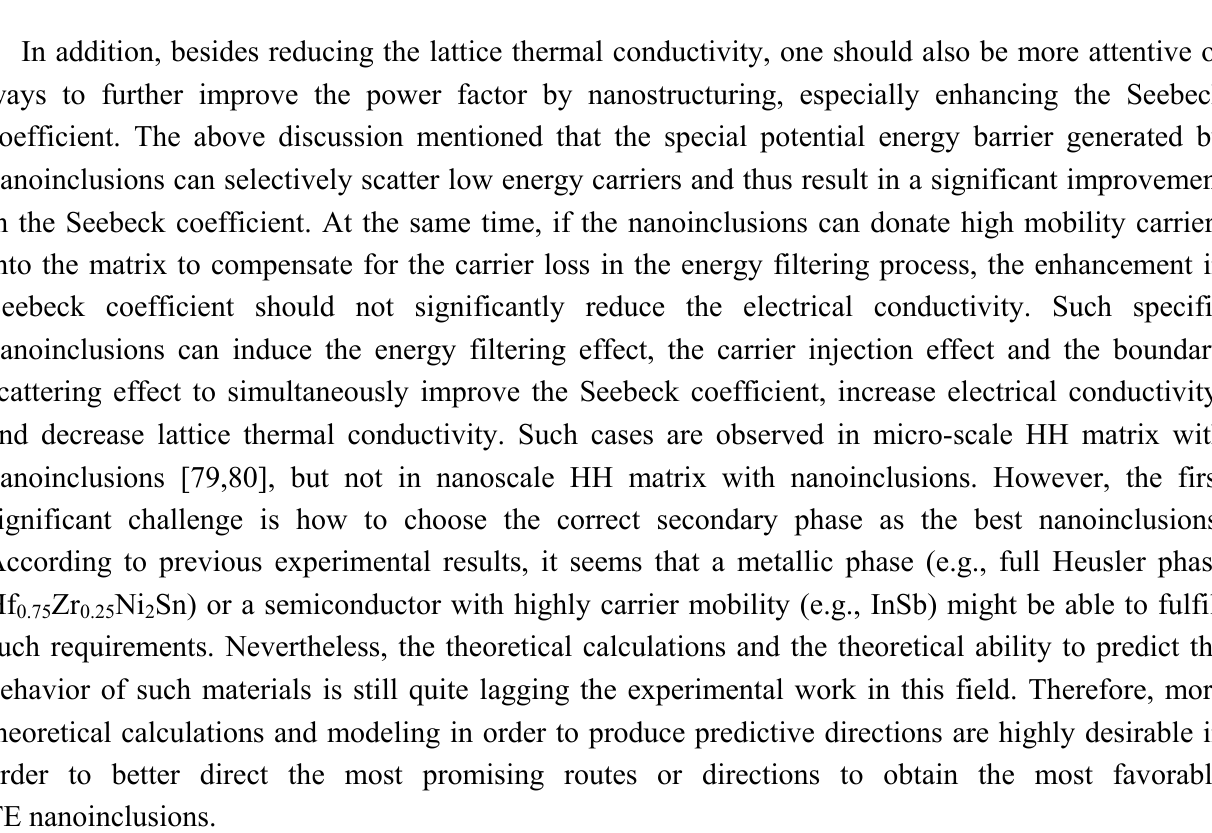
Figure 22. The lattice thermal conductivity of MSed Zr